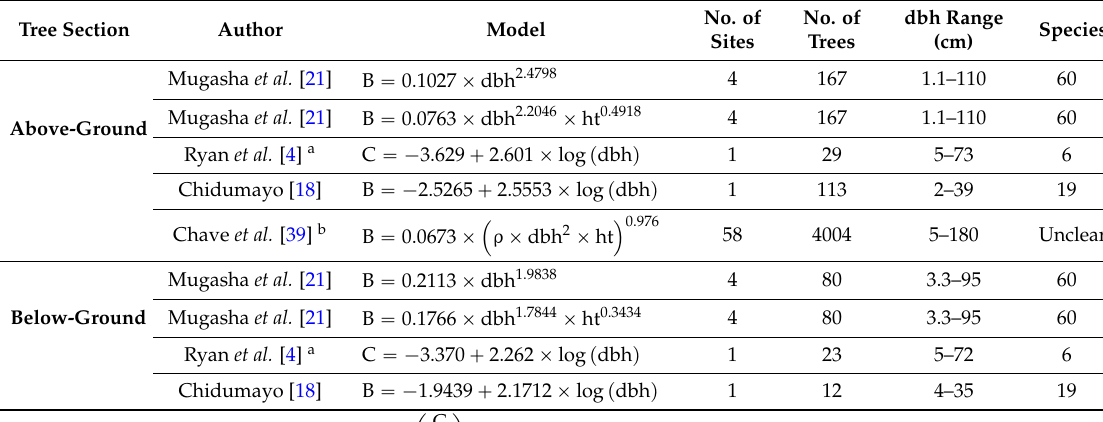
Table 3. Number of sites, sample trees and dbh ranges (cm) of previously developed models tested on our